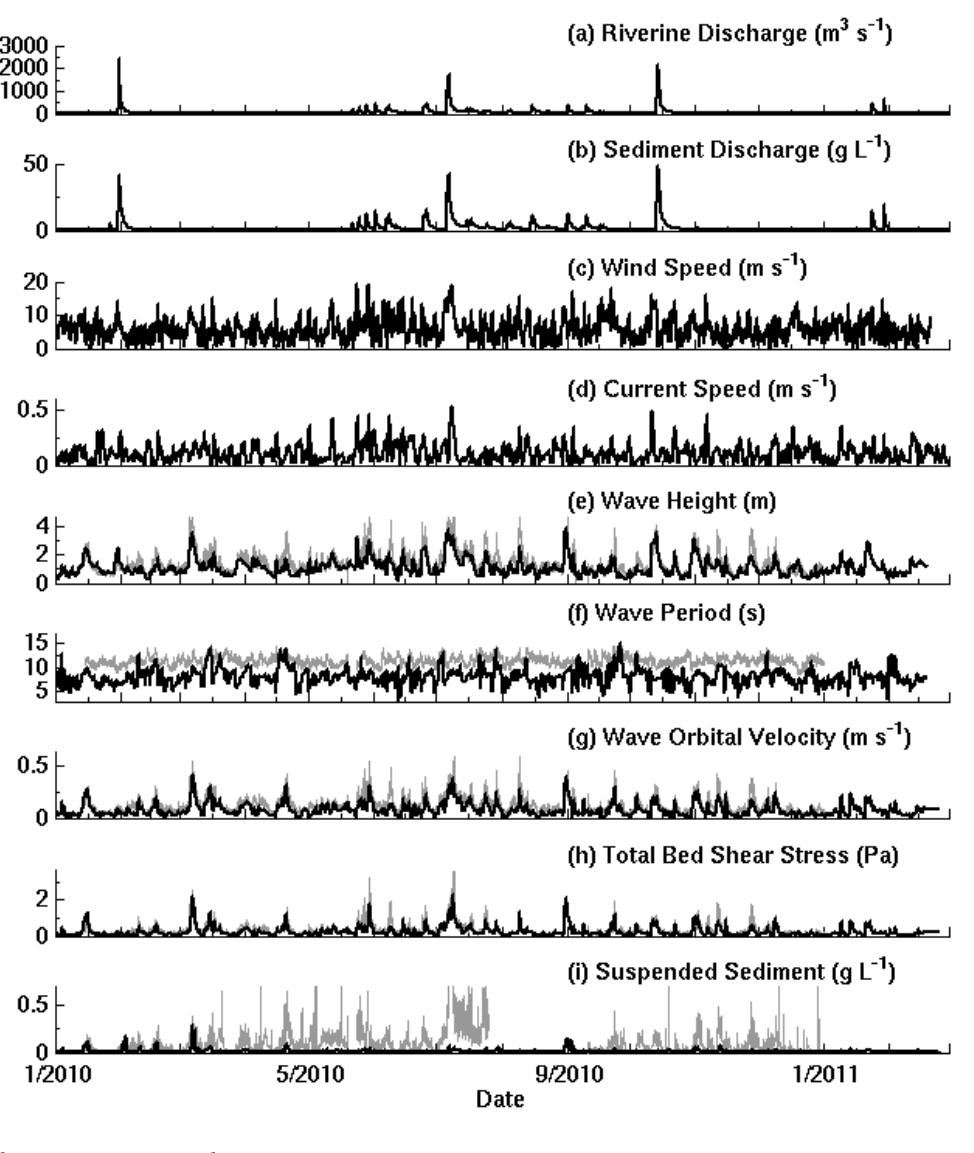
Figure 4. Time series of observed and estimated weather conditions on Waipaoa Shelf. ( a ) River and ( b ) sediment discharge from Gisborne District Council, New Zealand; modeled wind speed from New Zealand Limited Area Model (NZLAM) ( c ) and current speed from ROMS-NZ ( d ) averaged over the model domain; ( e ) significant wave height; ( f ) bottom wave period; ( g ) wave orbital velocity; ( h ) total wave- and current-induced bed shear stress; and ( i ) suspended sediment concentrations. For panels ( e )–( i ), black lines indicate model estimates made for the grid cell nearest the tripod site (see Figure 1b), and grey lines indicate acoustic Doppler velocimeter (ADV) (wave height; bed shear stress) and optical backscatter sensor (OBS) (suspended sediment concentration) observations provided by Hale, R. and Ogston, A. (University of Washington; [30]) from the tripod at 40 m water